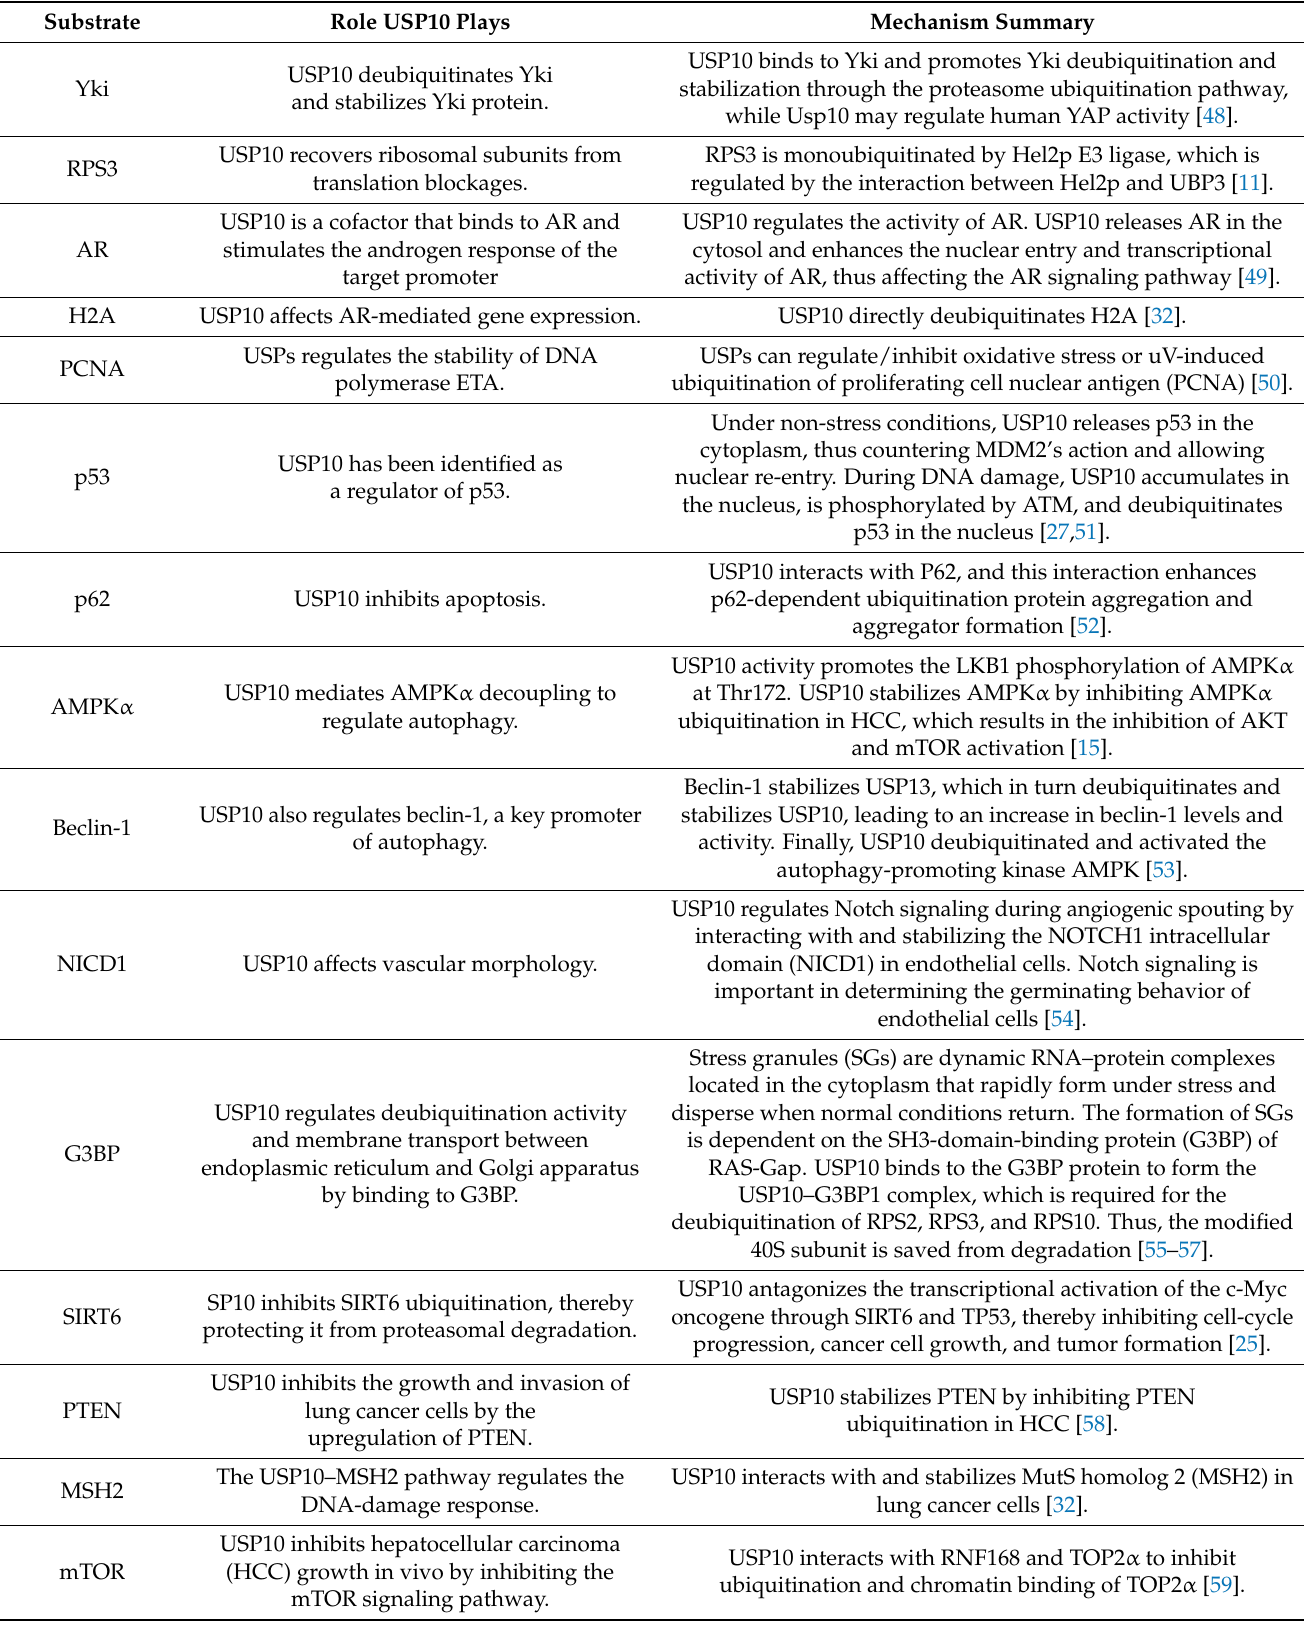
Table 1. Summary of the identified deubiquitination substrates for